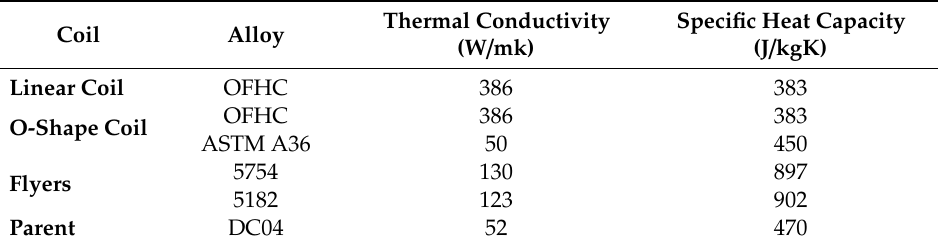
Table 7. Thermal properties.